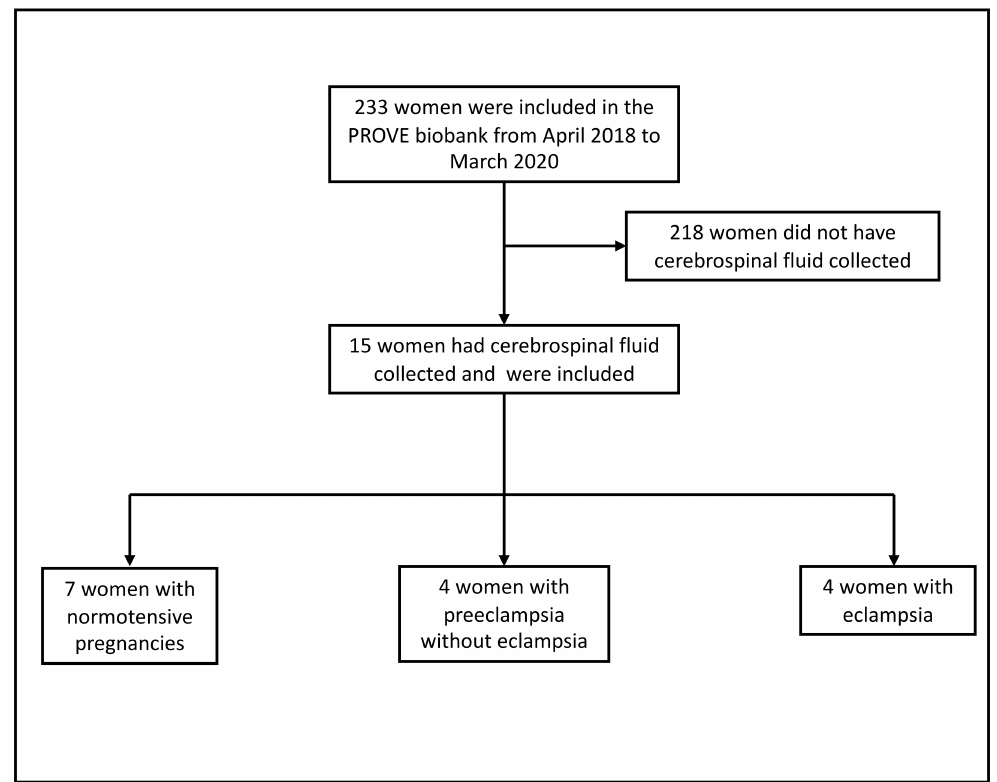
Figure 1. Background characteristics.